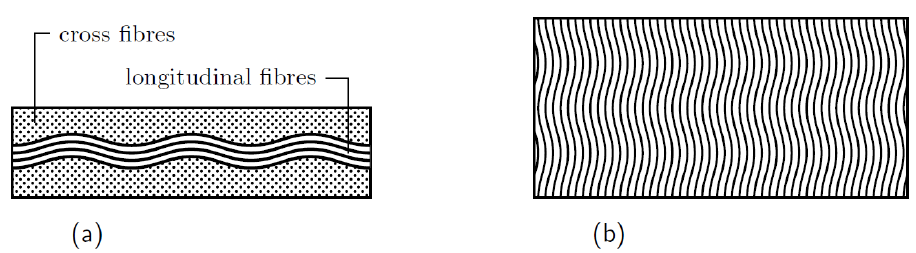
Figure 4. ( a ) Out-of plane fibre waviness in thick composite (section), ( b ) In-plane fibre waviness (top